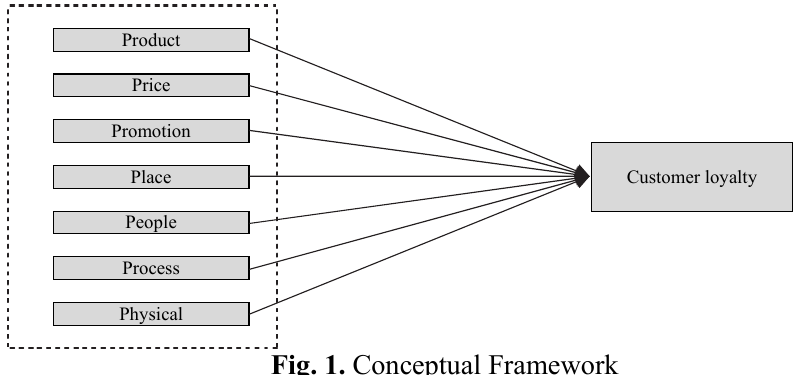
Fig. 1. Conceptual